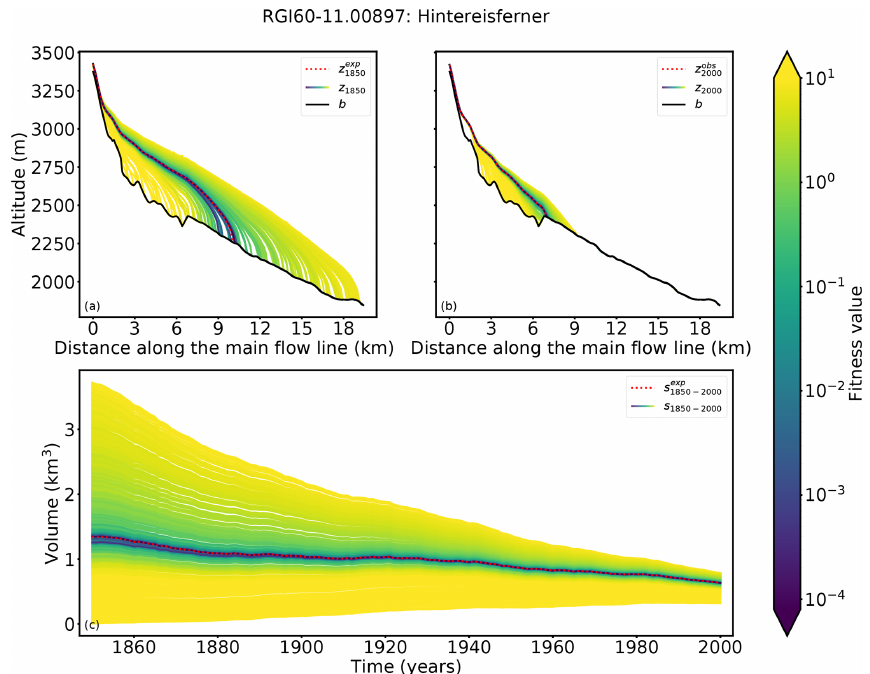
Figure 5. Results for Hintereisferner (Ötztal, Austria). Cross sections along the main flow line in (a) 1850 and (b) 2000 are shown. Black line indicates the bedrock, the red dotted line the surface elevation from the synthetic experiment, and the remaining lines the modeled ice surfaces of all candidates, colored by their fitness value. The synthetic experiment state in 2000 has a length of 7.3km, an area of 7.76km 2 , a volume of 0.63km 3 , and a mean thickness of 105.5m. (c) Volume changes from 1850 to 2000, colored by their fitness values. All violet and blue glacier states merge to the observed glacier in